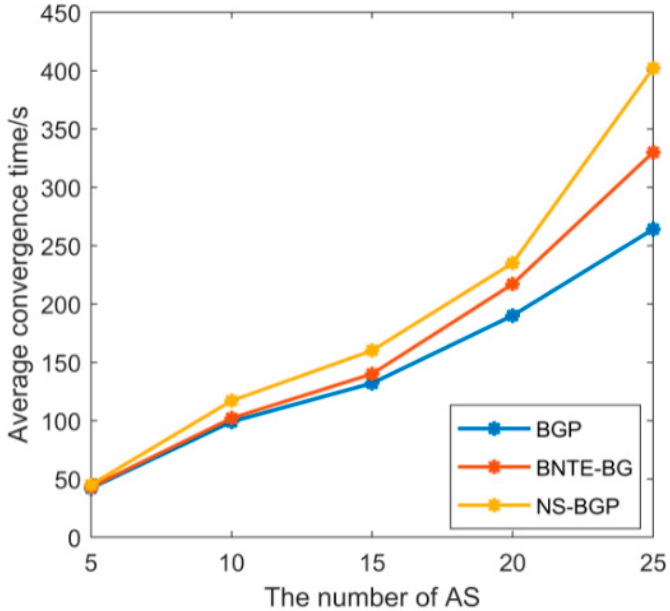
Figure 6. Average convergence time.